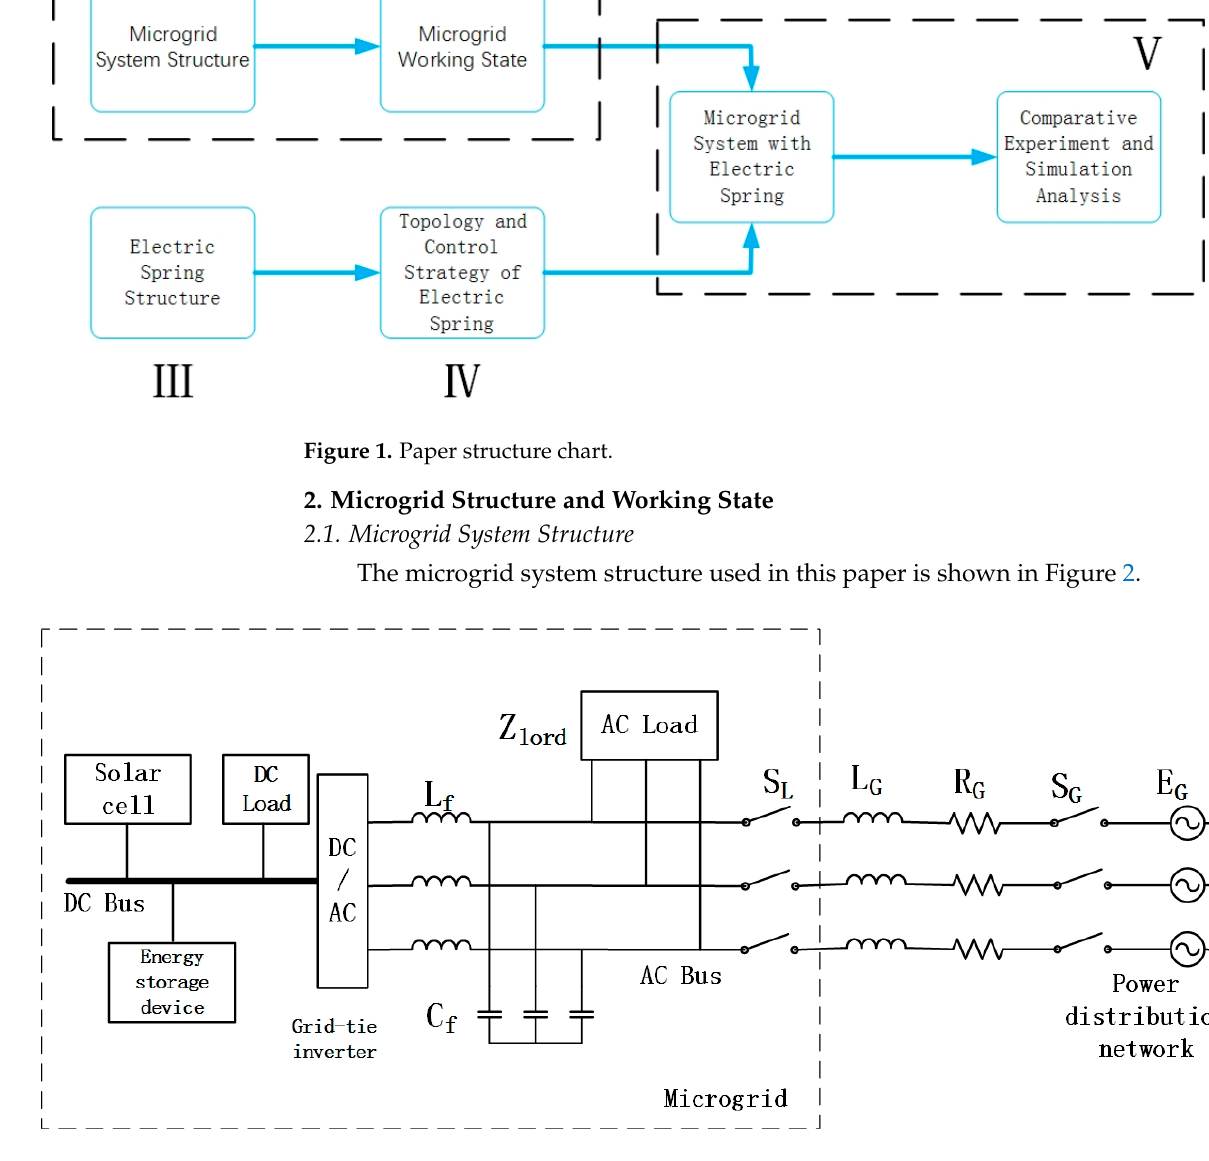
Figure 2. AC/DC hybrid microgrid system structure.